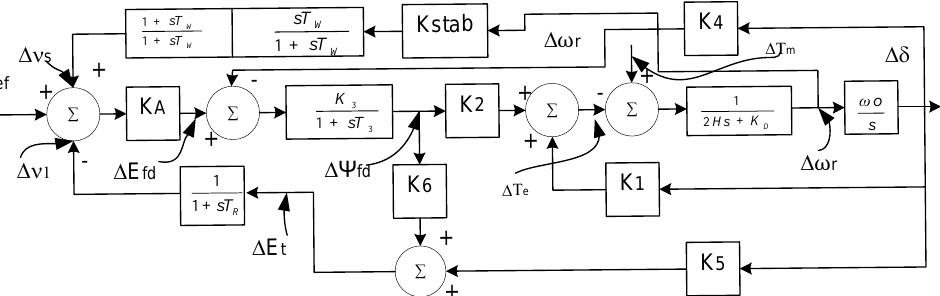
Figure 3. Block diagram the SMIB with a PSS, AVR, and exciter.